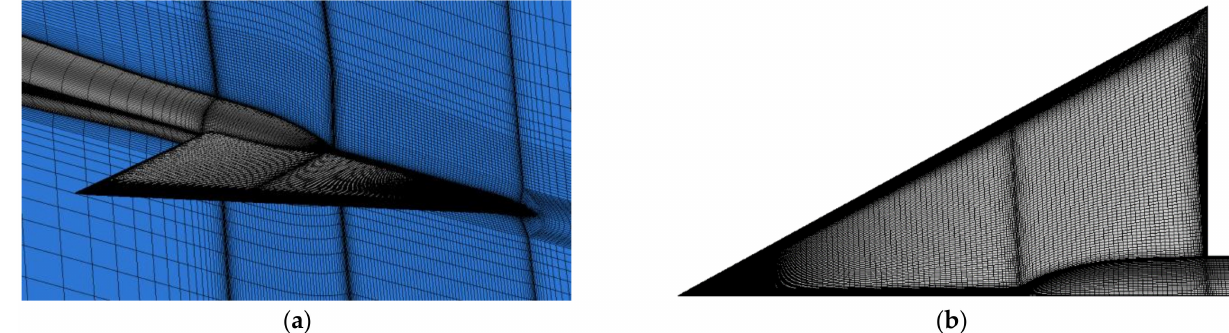
Figure 5. The grid of delta wing. ( a ) Volume grid; ( b ) Surface grid.